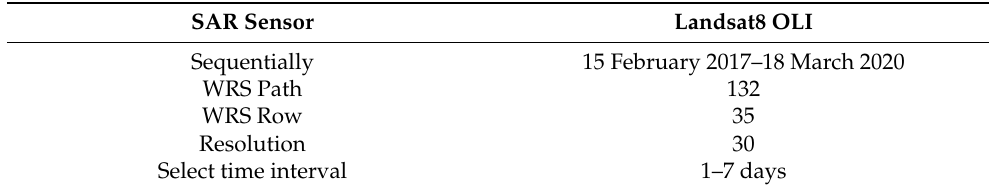
Table 3. Landsat8 OLI data